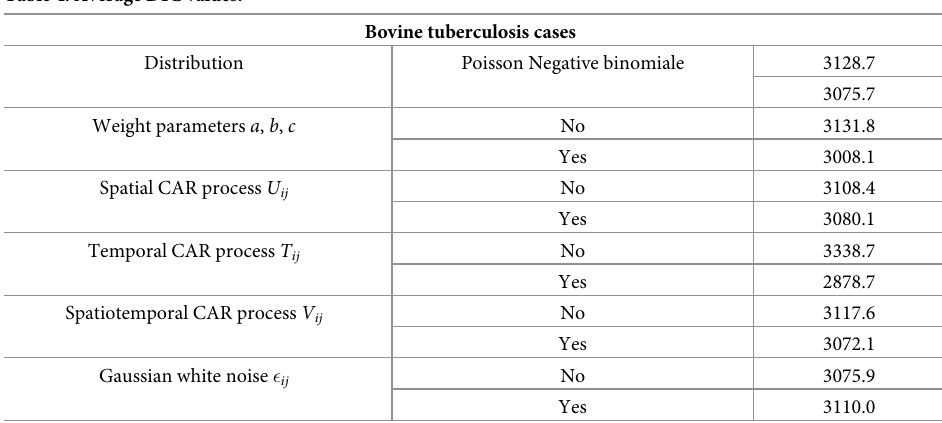
Table 4. Average DIC